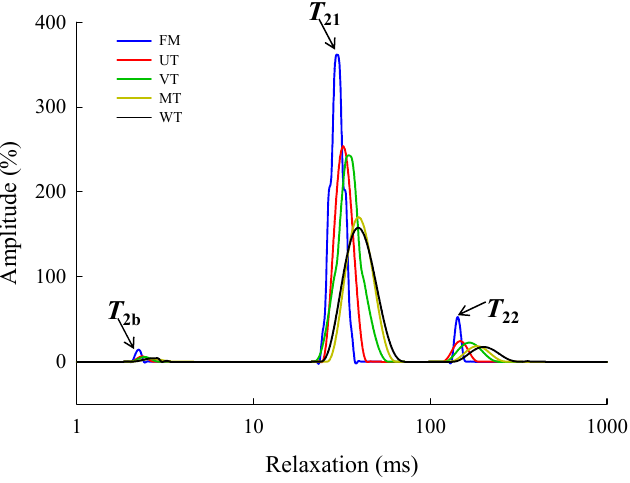
Figure 1. Change in distribution of the LF-NMR relaxation times of porcine longissimus dorsi induced by thawing methods. FM, fresh meat; UT, ultrasonic thawing (20 °C); VT, vacuum thawing (25 °C); MT, microwave thawing; WT, water immersion thawing (14 °C). Table 4. Change in distribution of the T 2 relaxation time and the P 2 ( T 2 peak ratio) of porcine longis- simus dorsi induced by thawing methods.